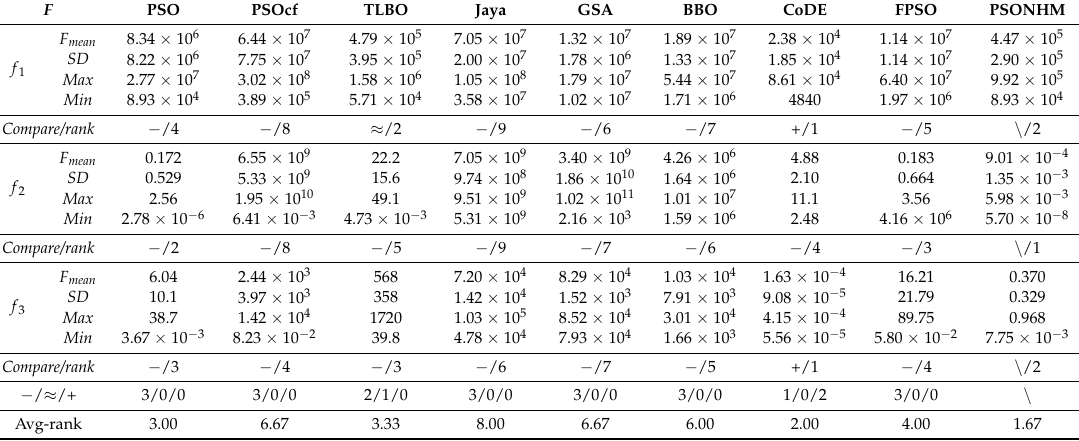
Table 2. Experimental results of PSO, PSOcf, TLBO, Jaya, GSA, BBO, CoDE, FPSO and PSONHM on f 1 – f 3